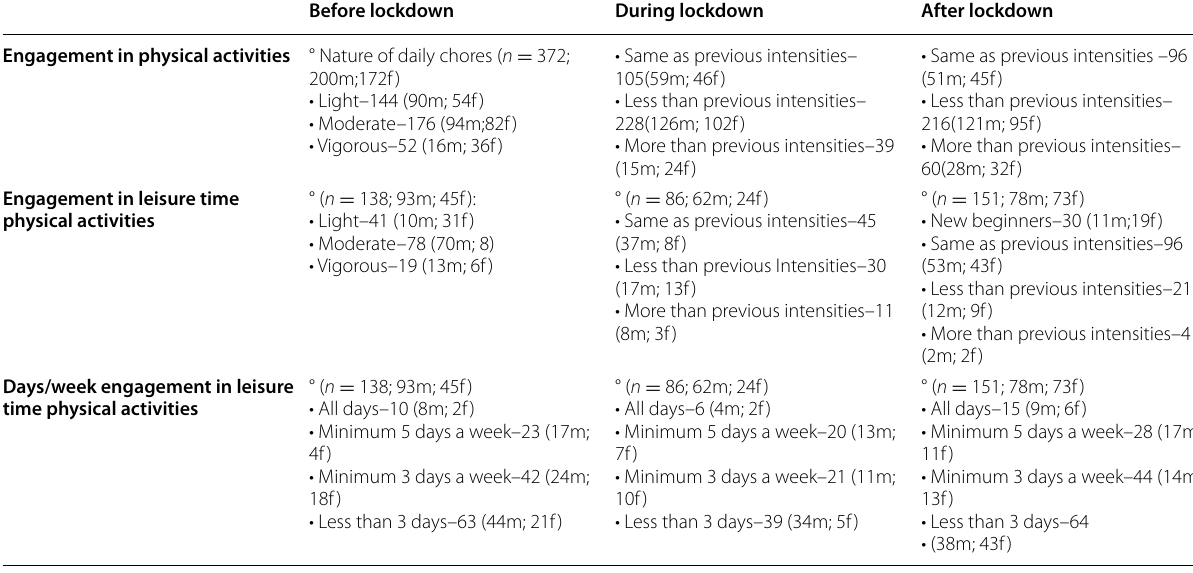
Table 2 Physical activity patterns of the participants before, during, and after the introduction of lockdown measures Before lockdown During lockdown After lockdown Engagement in physical activities ° Nature of daily chores ( n 372; = 200m;172f)